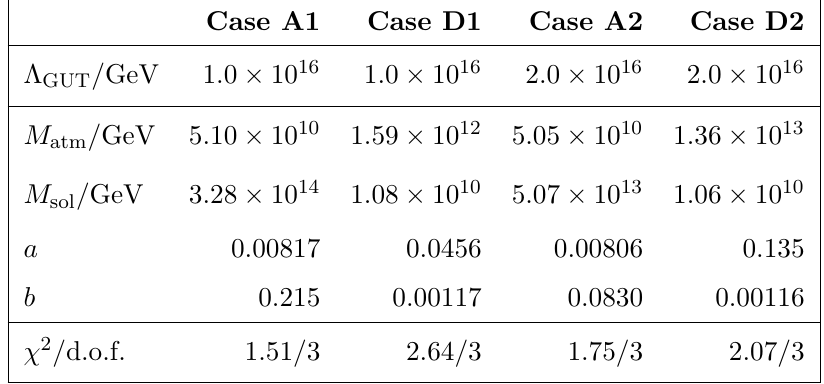
Table 2 . Benchmark Point